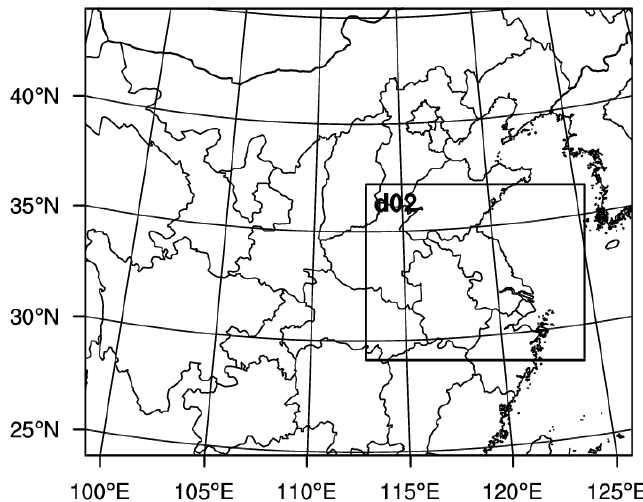
Figure 1. Configuration of model domains. The inner domain (d02) is the analysis region.